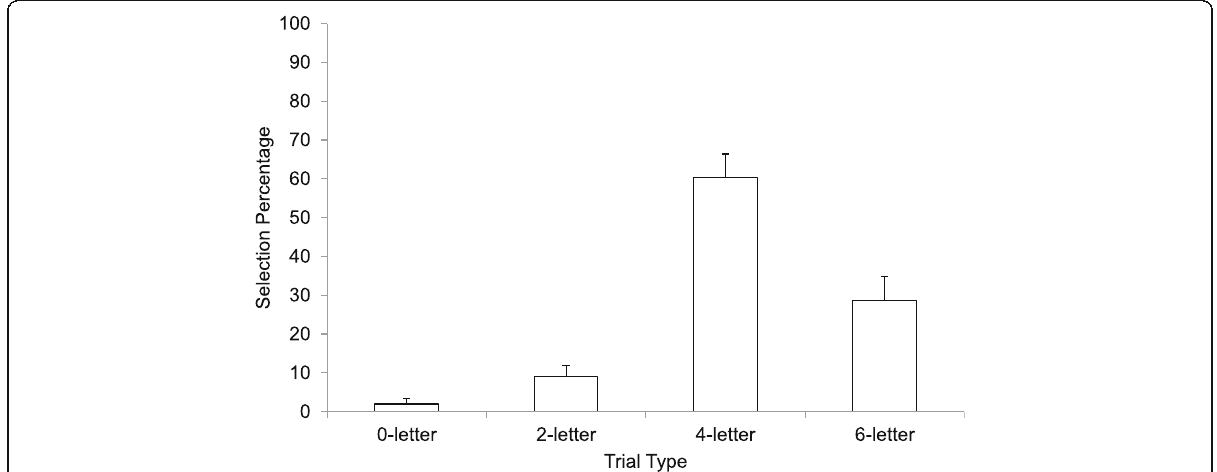
Fig. 1 Selection rate (reported as a percentage) as a function of trial type in Experiment 1. Error bars report standard error of the